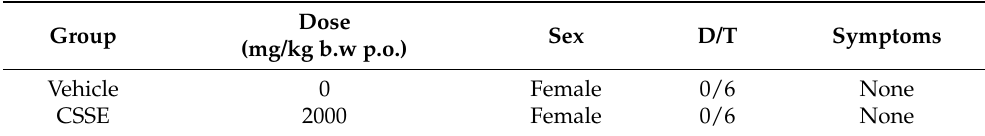
Table 1. Effect of oral administration of a single dose of CSSE (2000 mg/kg, b.w) on the behavior and mortality of mice. Dose Group (mg/kg b.w p.o.)